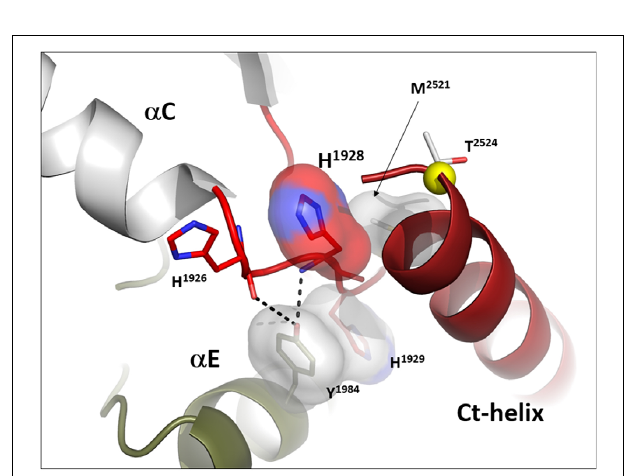
FIGURE 5 | The α C- β 4 Loop in LRRK2 is an interface between the C-terminal helix that follows the WD 40 domain. The α C- β 4 Loop of LRRK2 is also anchored to the α E-Helix through a conserved Y1984 in α E and H1929 at the tip of the α C- β 4Loop. H1928, analogous to R509 in BRaf is part of the docking interface for the Ct-helix. T2524 is a putative docking site for a 14-3-3 (Manschwetus et al., 2020). of the ATP binding site in the kinase domain is a critical switch that controls the conformation of RCKW. They